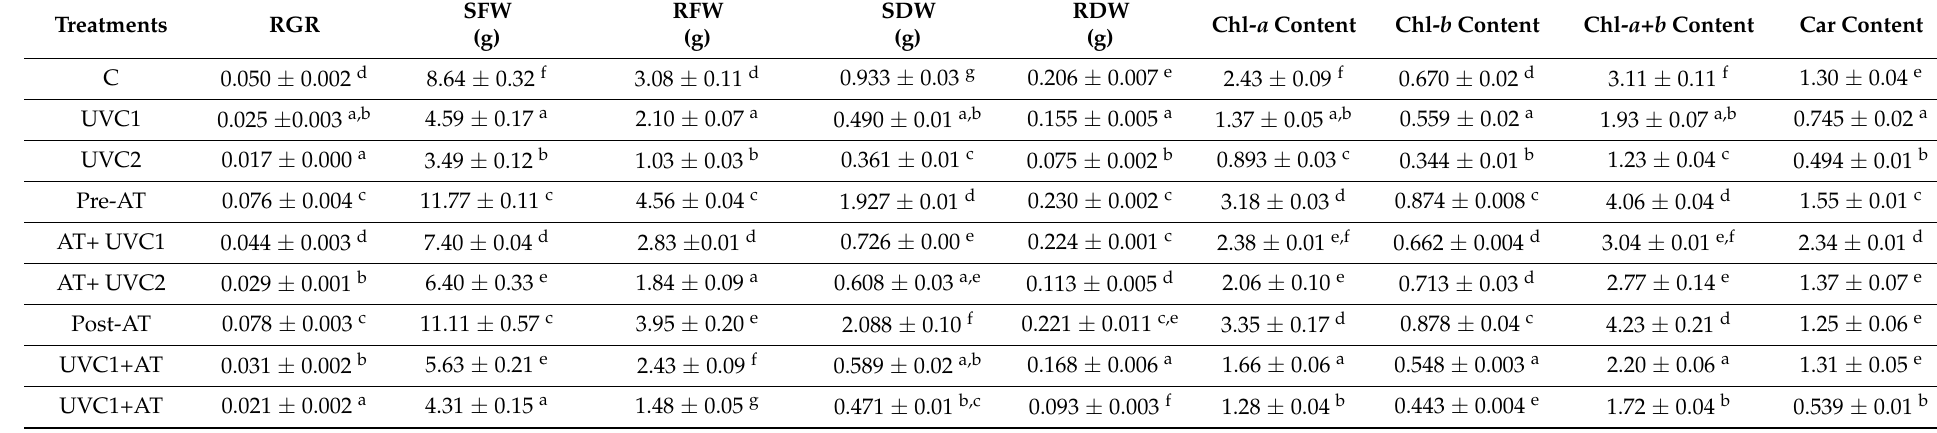
Values are means ± standard deviation (SDs) ( n = 5). Means followed by the same letter are non-significant among the treatments within the same column at p ≤ 0.05 considering Tukey’s test. RGR, relative growth rate, SFW, shoot fresh weight; RFW, root fresh weight; SDW, shoot dry weight; RDW, root dry weight; chlorophyll (Chl)- a (mg g − 1 FW); Chl- b (mg g − 1 FW); Chl- a+b (mg g − 1 FW), and carotenoids